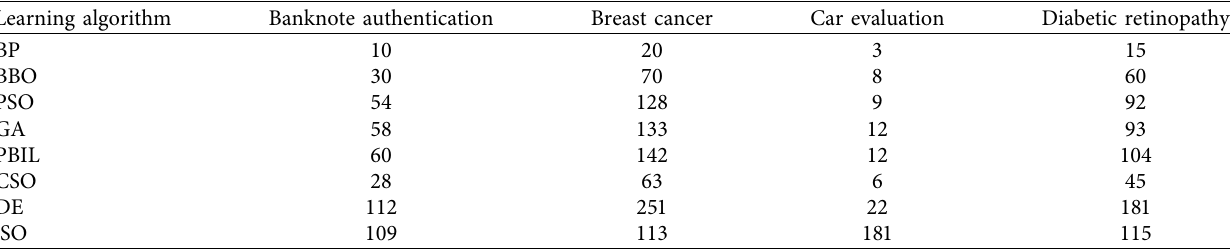
Table 7: Average running time (sec) of each algorithm in different